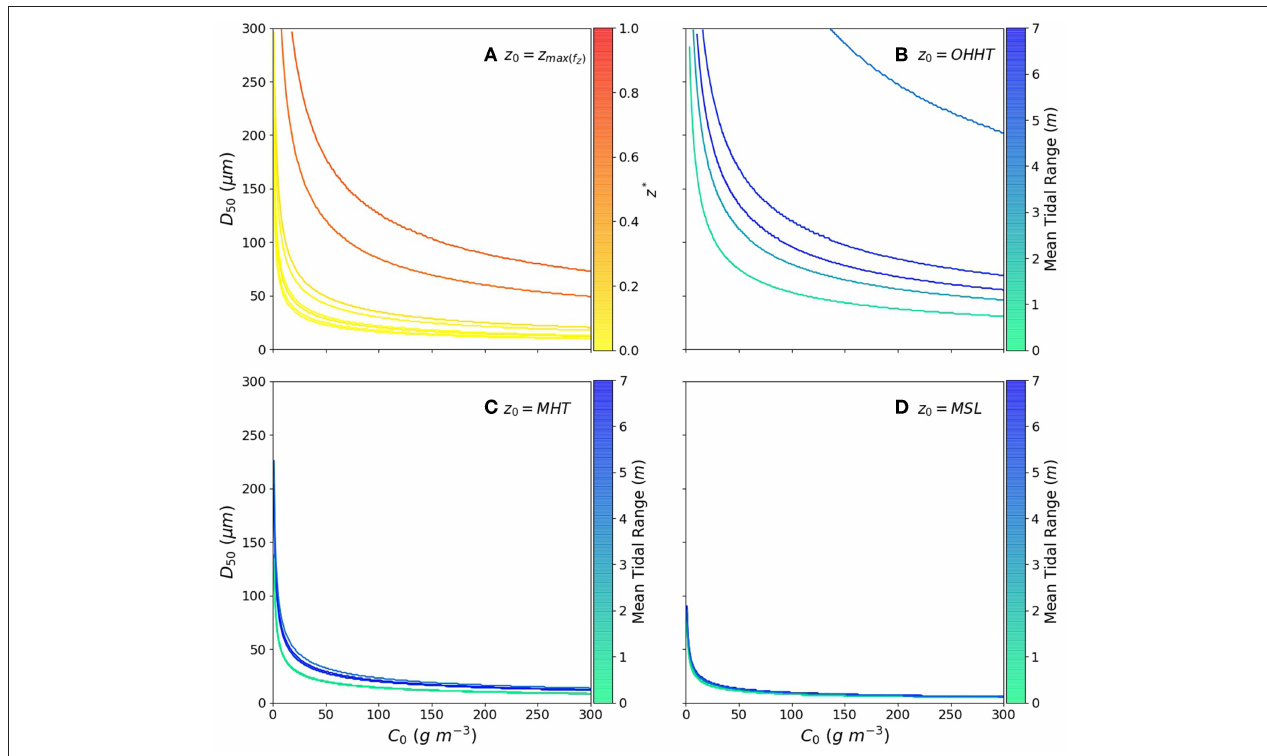
FIGURE 8 | Necessary values of C 0 and D 50 for total accretion to reach k = 2.5 mm y − 1 ; (A) initial elevation z 0 = z max ( f (C) z 0 = MHT . (D) z 0 = MSL ; the last three subplots are colored by mean tidal